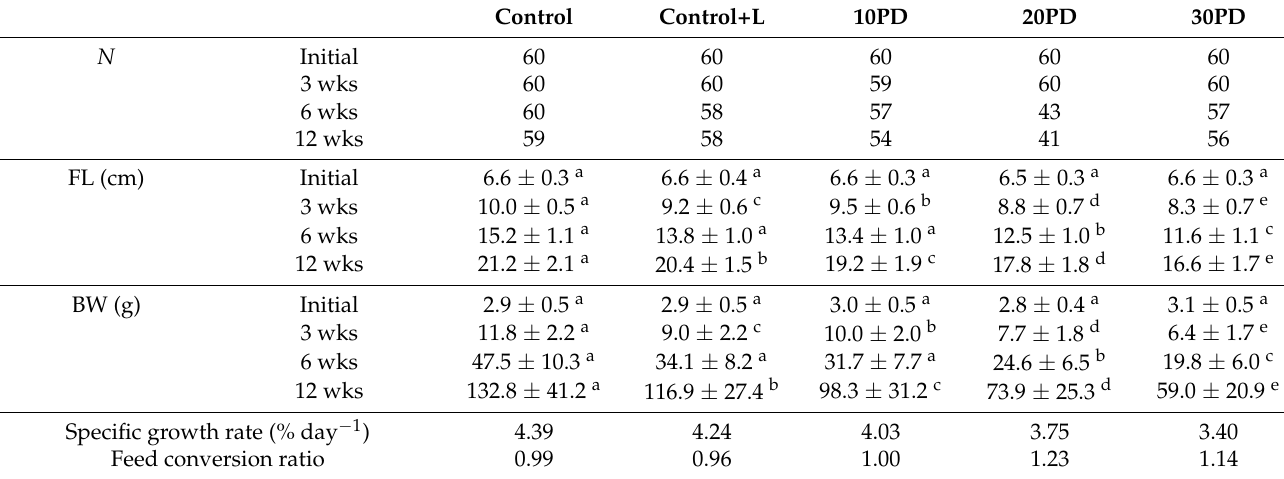
Table 6. Growth of juvenile yellowtail in feeding trial 1.